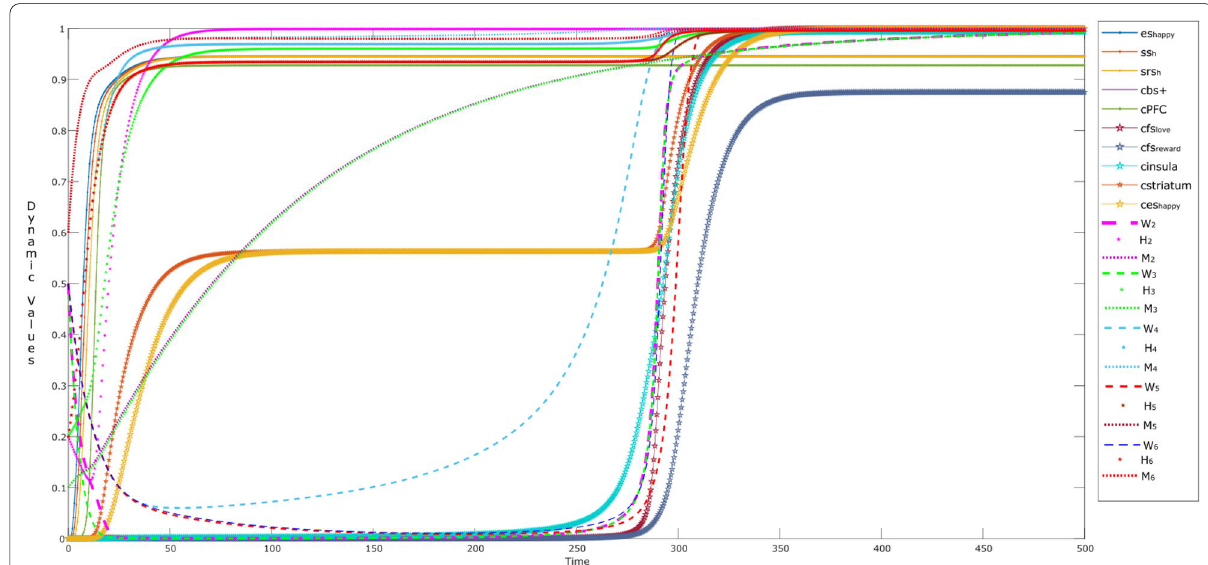
Fig. 3 Child is mimicking his/her parent’s behavior as (s)he senses happiness (input: es happy ), along with